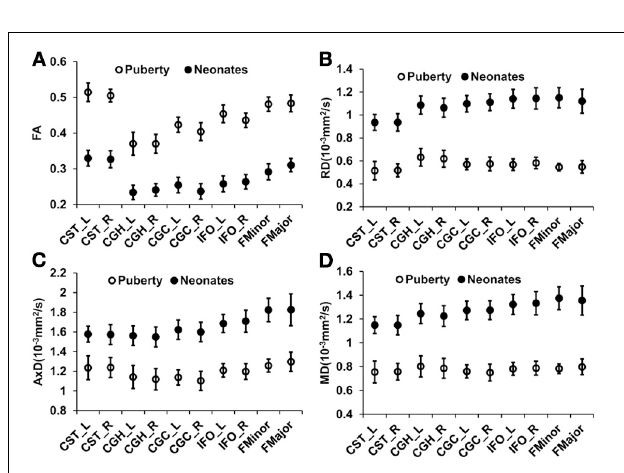
FIGURE 2 | Mean and standard deviation of tract-level FA (A), RD (B), AxD (C), and MD (D) measurements for 26 neonates and 28 children around puberty for all the 10WM tracts. Error bars indicate standard deviations across all the subjects at the same age